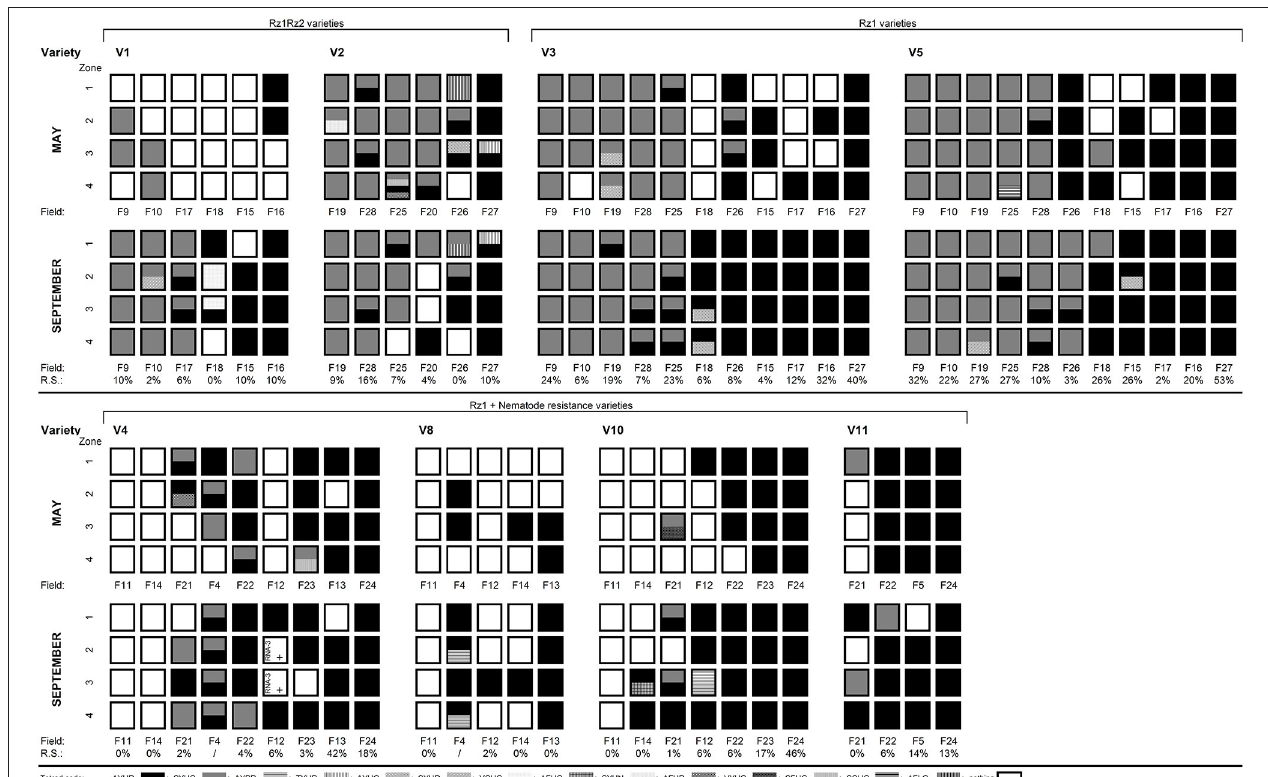
FIGURE 2 | Tetrad diversity for Beet necrotic yellow vein virus (BNYVV) isolates by cultivar between year 1 and year 3 for samples collected from sugar beet fields in May and September in the region of Pithiviers of France. Each field was subdivided in four zones and three varietal bands. V1 and V2 were Rz1rz1Rz2rz2 tolerant cultivars. Cultivars V3 and V5 to V7 were Rz1rz1 tolerant cultivars. V4 and V8 to V13 were Rz1rz1 tolerant cultivars that also included tolerance to Heterodera schachtii . R.S. = root symptoms severity (%) observed in September is represented by R.S based on the observation of 2 times 50 roots in each cultivar band noted with frequencies of a scale ranking the level of root symptoms (0, no symptoms; 1, average root symptom between 0 and 50%; 2, strong root symptom between 50 and 100%). /, no information.